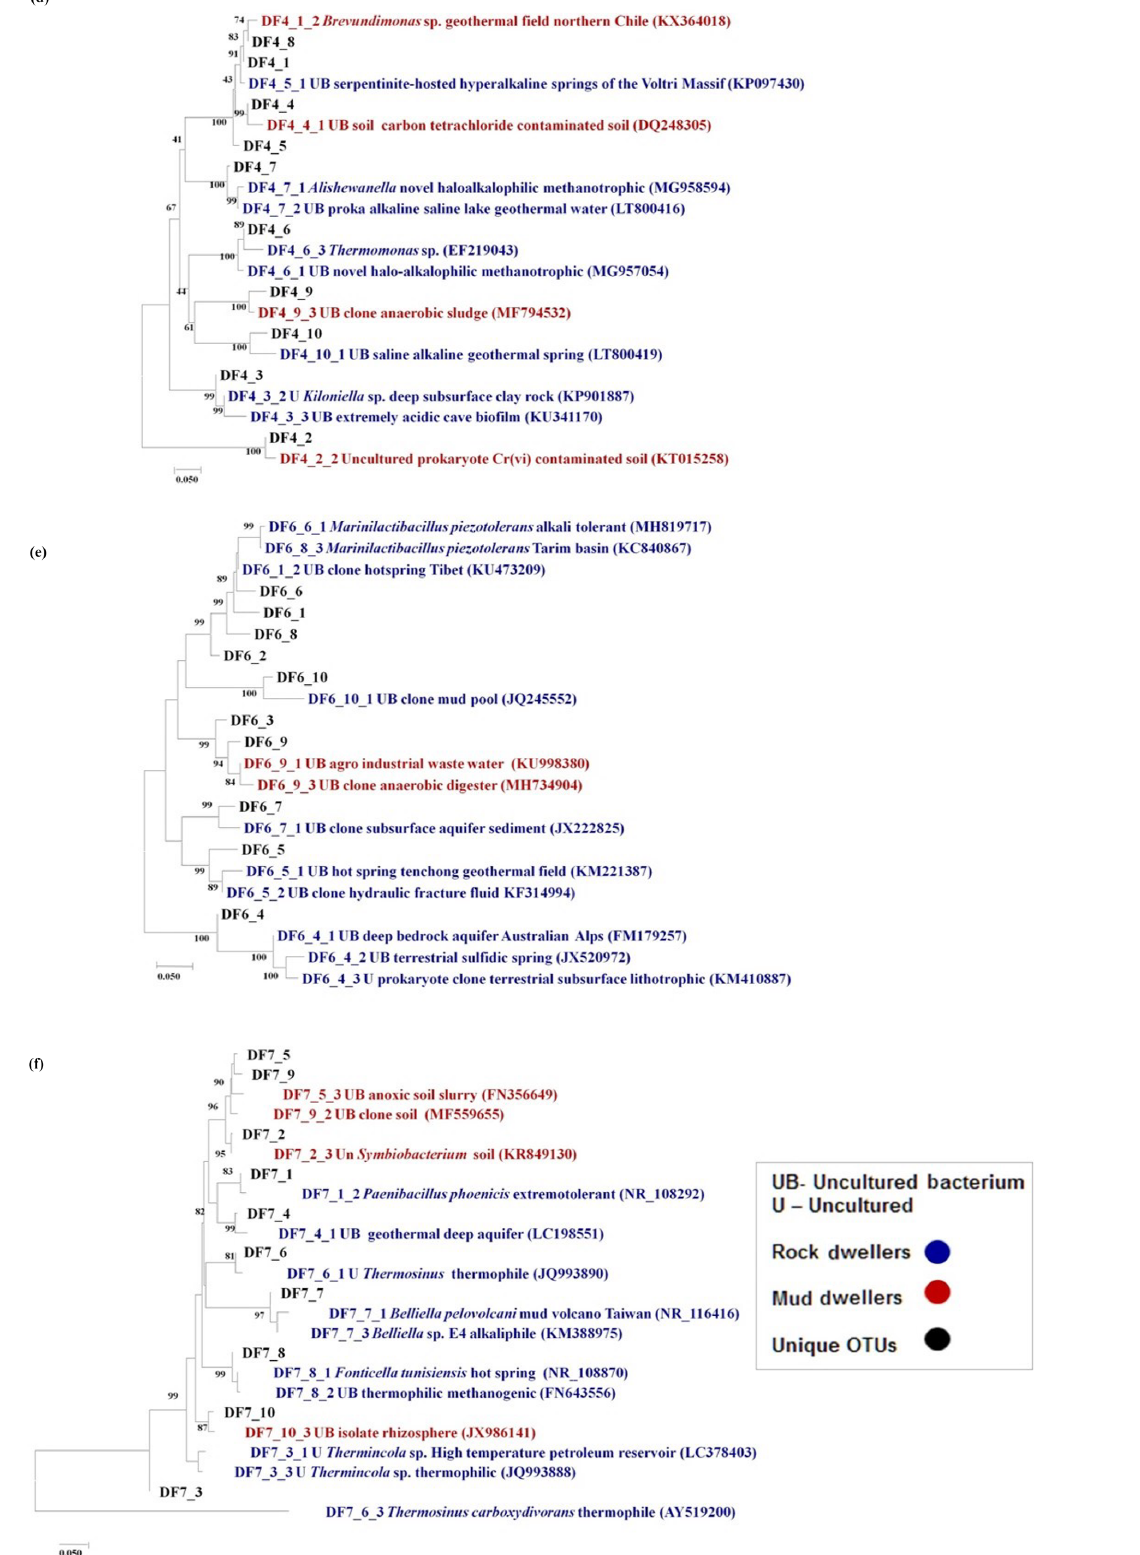
Figure 10. The phylogeny of the top 10 unique OTUs of DF1 (a) , DF2 (b) , DF3 (c) , DF4 (d) , DF6 (e) and DF7 (f) . A phylogenetic tree was constructed using MEGA 7